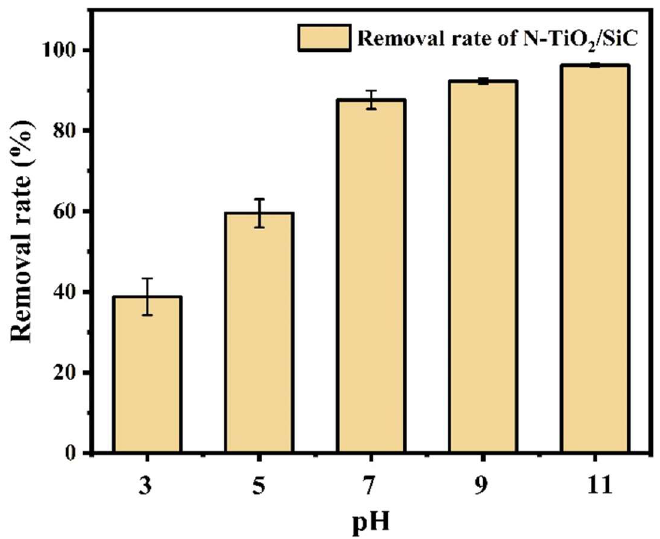
Figure 7. Effect of initial solution pH on the photocatalytic degradation